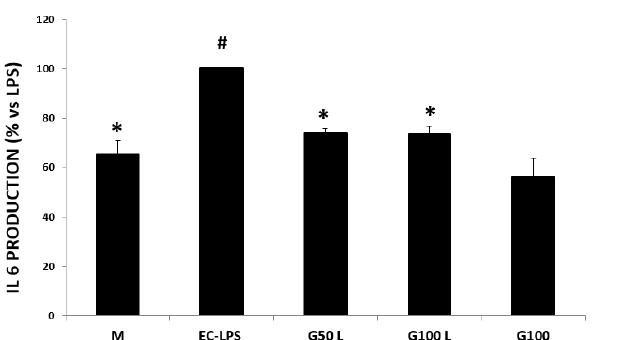
Figure 12. GAAE pre-treatment effect on IL-6 production in UC patients challenged with EC-LPS . Biopsies were treated only with medium culture (M), or with 1 mg/mL of EC-LPS or pretreated for 3 h with 50 and 100 µg/mL GAAE, then challenged for 18 h with EC-LPS (G50 L and G100 L) or treated only with 100 µg/mL GAAE (G100). Results are expressed as a percentage of each treatment with respect to EC-LPS ± S.E.M. ( N = 31), * p < 0.05 vs. EC-LPS, # p < 0.05 vs. medium (Student’s t -test).